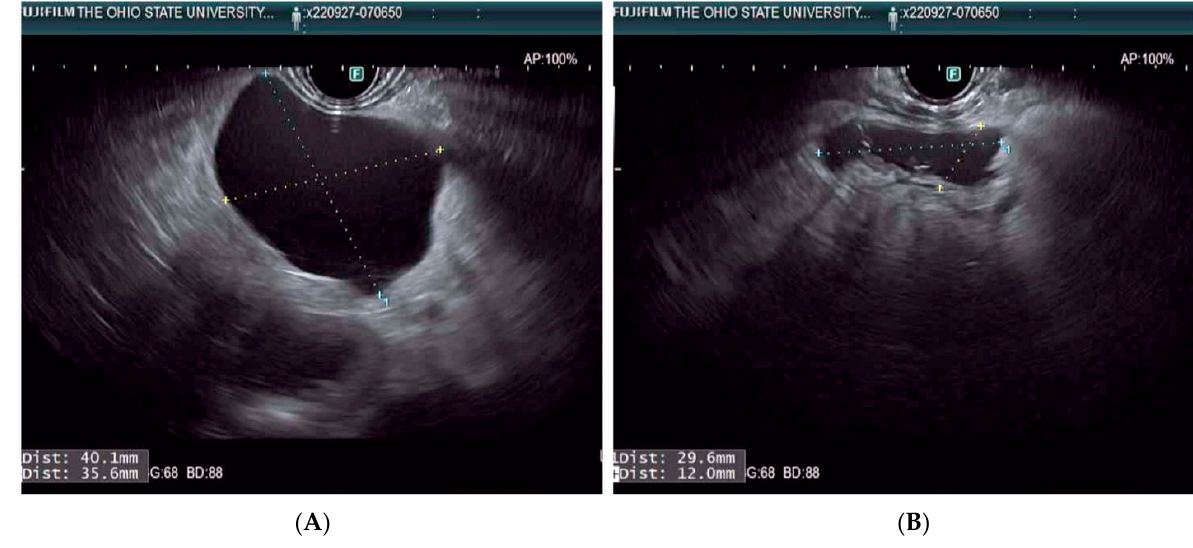
Figure 2. EUS-RFA of a BD-IPMN. Panel ( A ): pre-ablation, Panel ( B ): post-ablation. Based on multiple criteria, pancreatic cystic lesions with “high-risk stigmata” of ma- lignancy and some with “worrisome features” are considered for treatment. The current standard of treatment for these precancerous PCLs is surgical resection [46,55]. Almost two-thirds of these surgeries require pancreaticoduodenectomy, as most of these neo- plasms are found in the head of the pancreas [56,57]. While mortality for this highly-inva- sive surgery has improved over the last 20 years, the morbidity and complications have remained frustratingly constant [58,59]. Even minimally invasive surgical means of lapa- roscopic robotic-assisted pancreaticoduodenectomies have not been clearly shown to re- duce operative morbidity